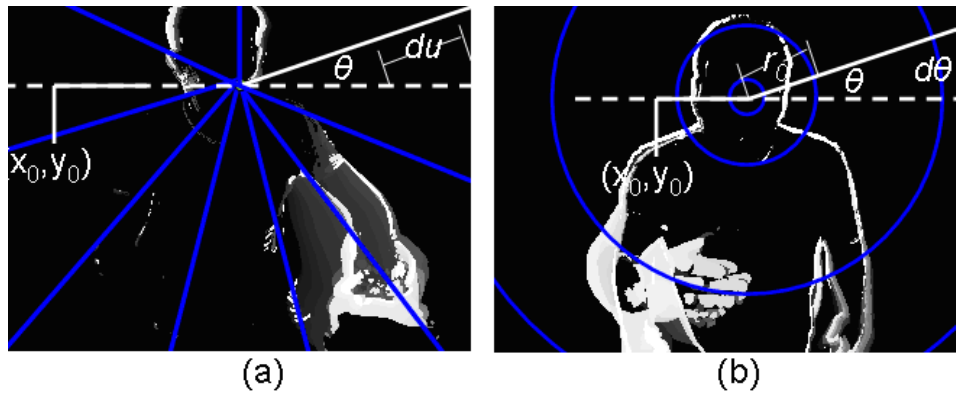
FIGURE 8 . (a) RIT and (b) CIT for activity